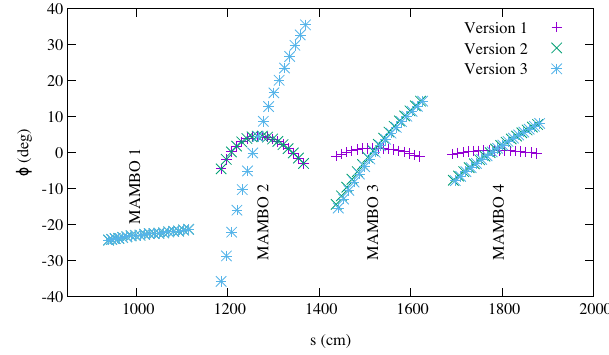
FIG. 4. Beam phases of the three versions of the normal conducting MAMBO.